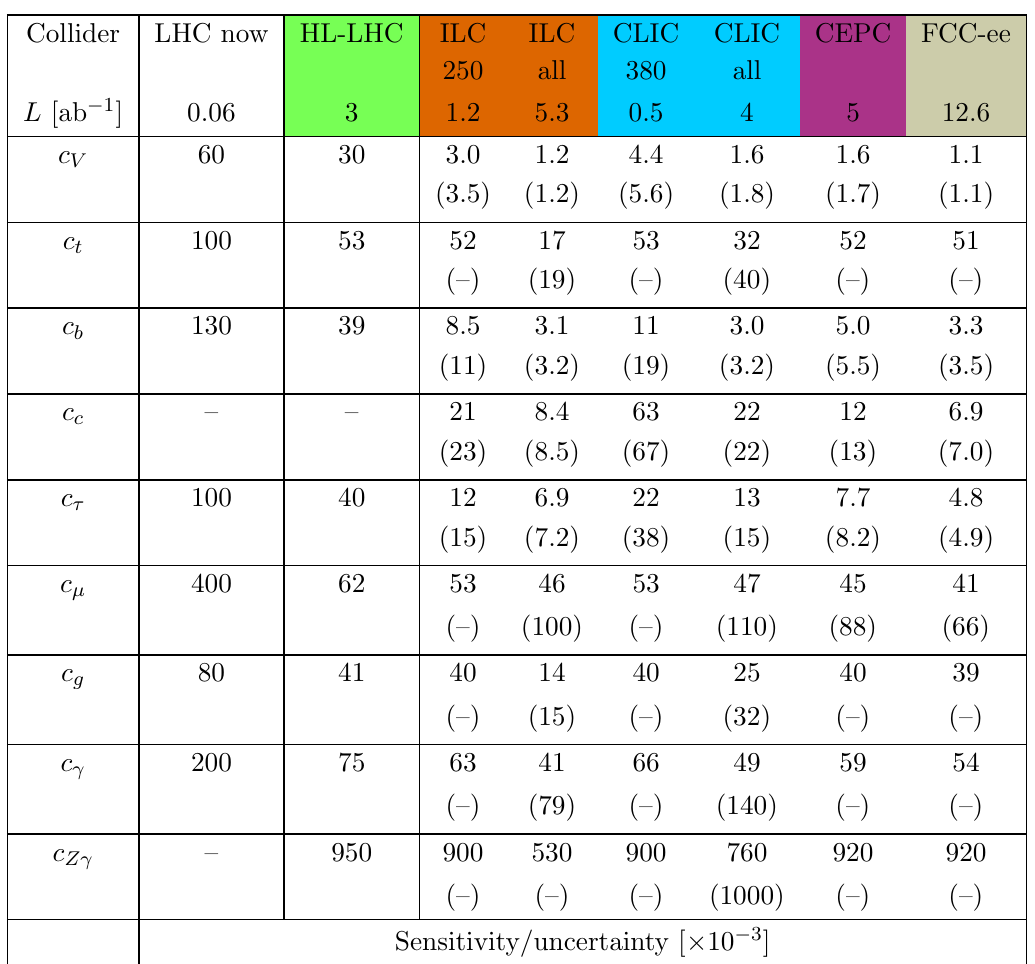
Table 4 . Projections for the 68% probability sensitivity to deviations from the SM Higgs interac- tions at various future colliders. The ILC, CLIC, CEPC and FCC numbers also include the (cid:12)nal HL-LHC results; their individual contributions are given in parentheses. We also show, for